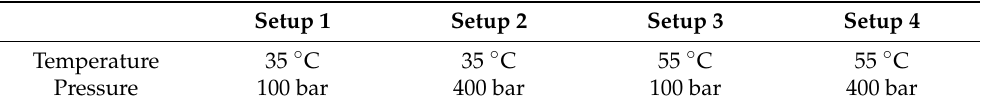
Table 1. Impregnation conditions.